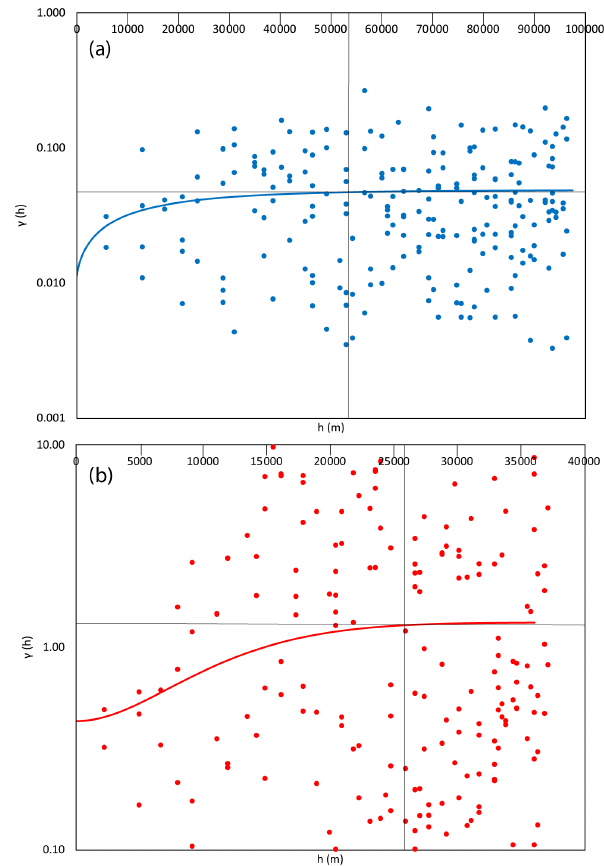
Figure 5. Observed values (points) and stable semivariogram mod- els (curves) for γ (h) in the case of (a) Matthew and (b) Florence. X axis is in meters. Y axis is a log-scale. Vertical line denotes the range ( a ) and horizontal line the sill ( C o ) (see Table 4).